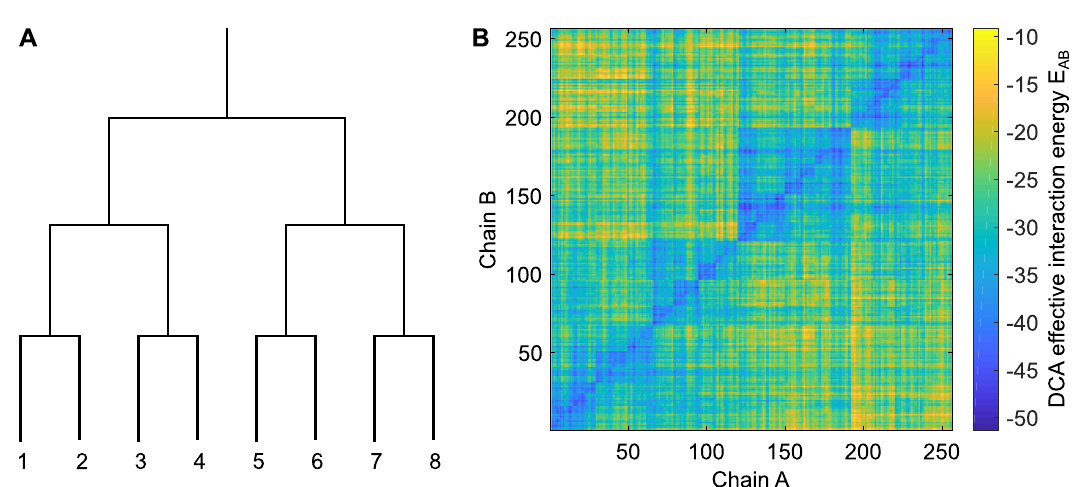
Fig 2. Pairs of chains with common evolutionary history have small DCA effective interaction energies. A : Chains are numbered according to the phylogenetic tree representing the branching process used for data generation (see Fig 1). The same numbering is employed for chains A and for chains B that possess the same evolutionary history. B : Matrix of DCA effective interaction energies E AB (Eq 1) for all pairs AB made from a chain A and a chain B of the testing set, numbered according to phylogeny as illustrated in panel A. Data was generated using a tree of 10 generations, with exactly 5 mutations per branch, out of 200 bits in each chain AB, thus yielding 1024 chains AB. Next, 75% of them were randomly selected to form the training set employed to build the DCA model, while the remaining 25% constitute the testing set.